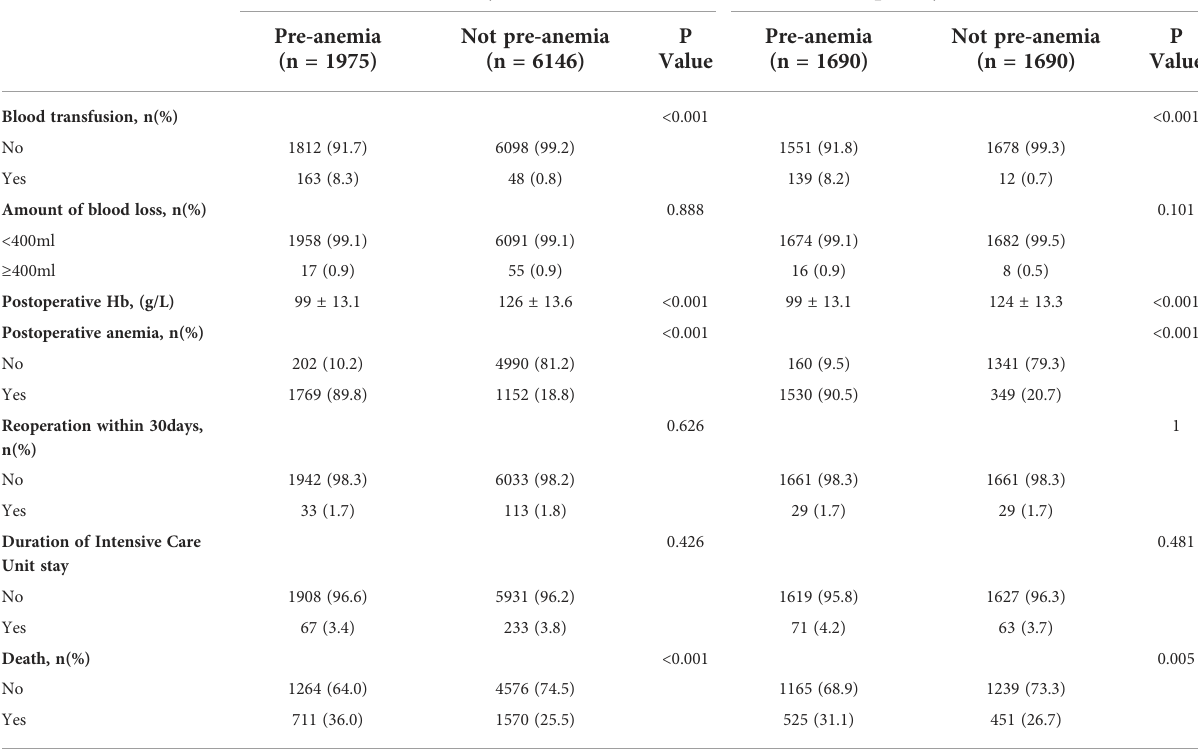
TABLE 2 The outcome of patients in the total study cohort and the Propensity score matched cohort.